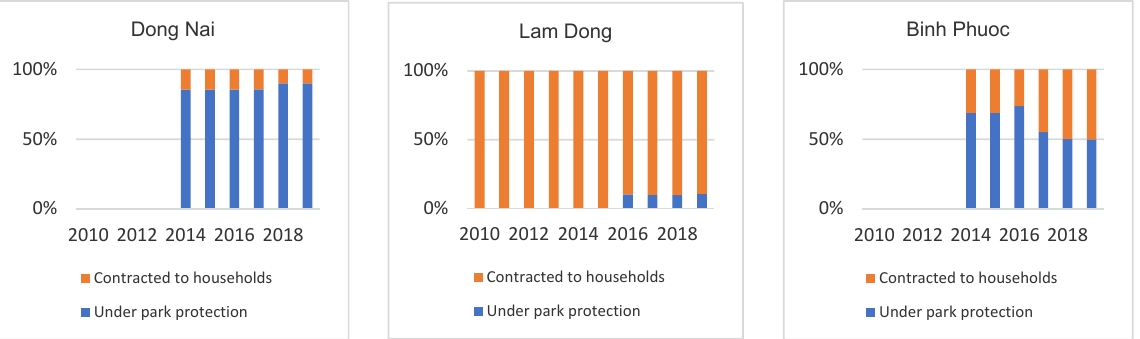
Figure 5. Area of Cat Tien National Park under park protection and contracted to local households. Source: Cat Tien National Park (2019).